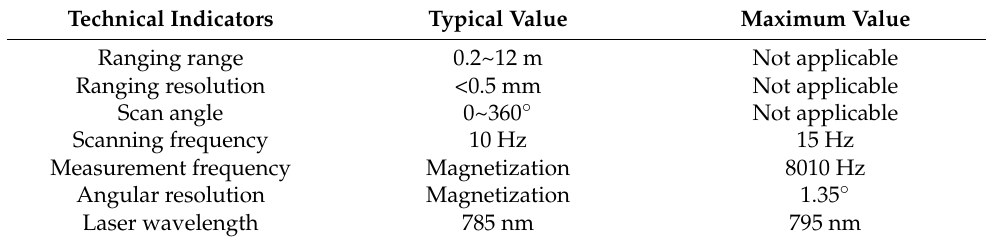
Figure 7. Schematic diagram of the sensor installation positions. Table 1. Main parameters of the RPLIDAR A2 Lidar. Table 1. Main parameters of the RPLIDAR A2 Lidar.